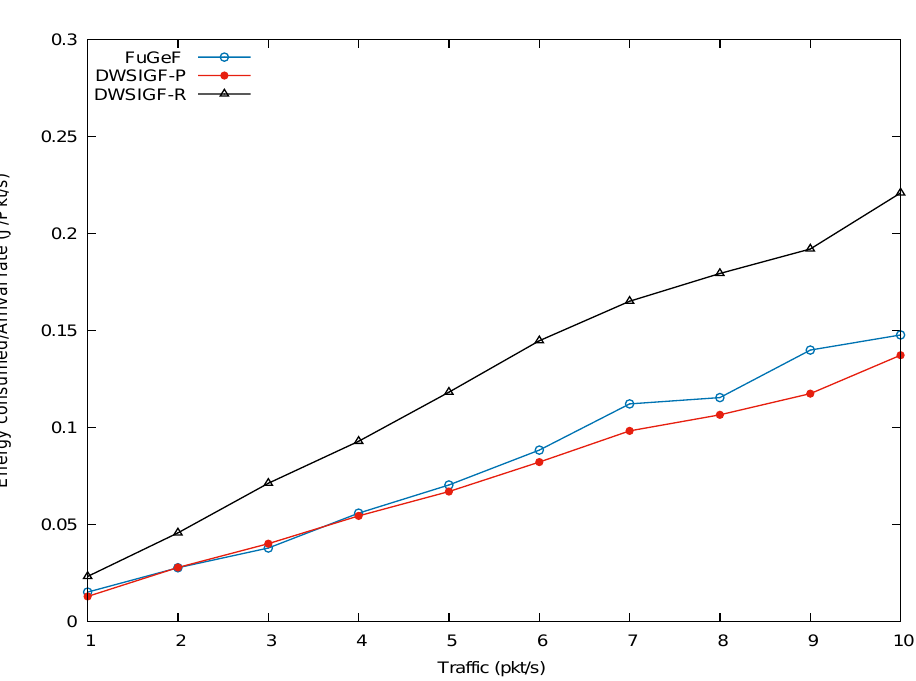
Figure 9. Packet Delivery Ratio (PDR).